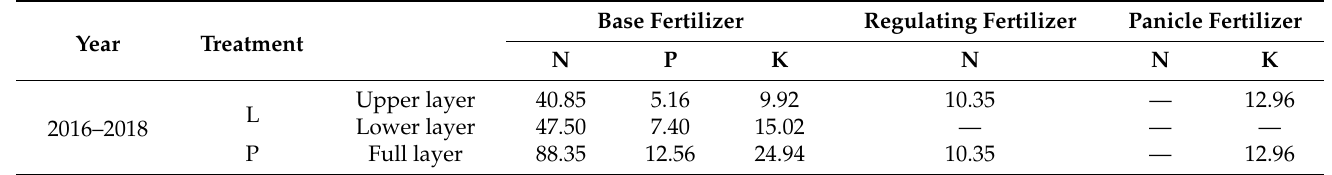
Table 1. Types and application rates of fertilization at Daqing Campus from 2016 to 2018 (kg/ha).